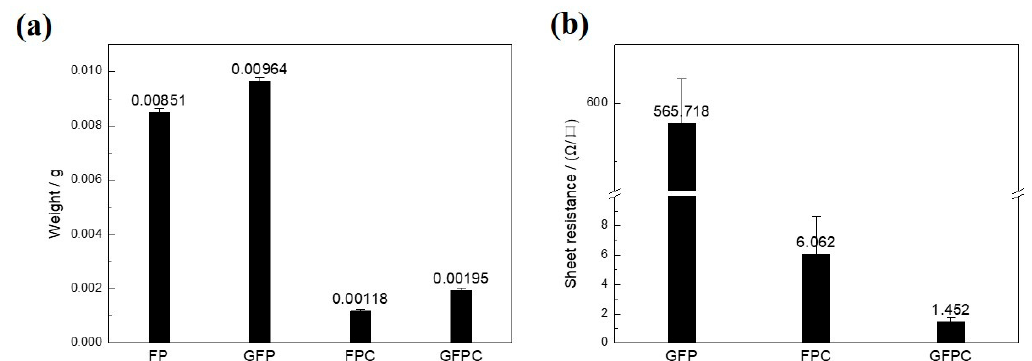
Figure 5. ( a ) The average weight of materials of FP, GFP, FPC, and GFPC, ( b ) the sheet resistance of GFP, FPC, and GFPC.